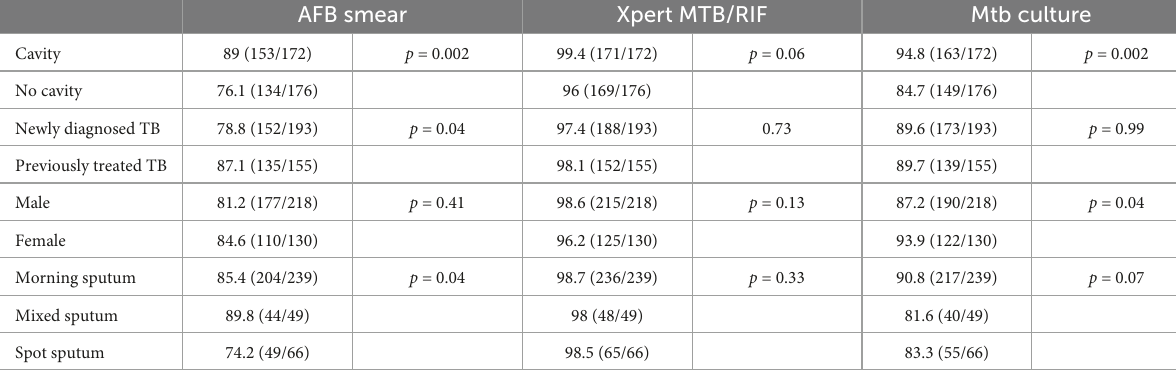
TABLE 3 The positivity of AFB smear, Xpert, and Mtb culture by presence of cavity, new and previous treatment, gender, and sputum type, compared to composite results of the three methods. AFB smear Xpert